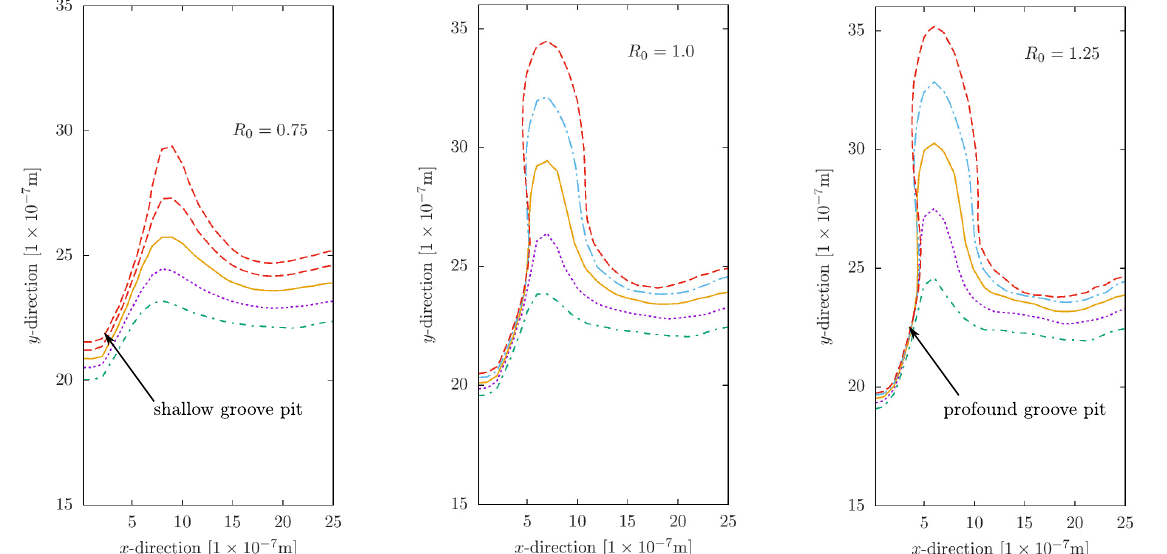
Figure 3. Effect of groove shape on the morphological development of primary ridges near a grain boundary. An increase in the ratio R 0 , where R 0 is the ratio between solid–solid γ gb to solid–liquid interfacial energies γ sl increases the local amplification of the ridge shaped instability. In contrast, a shallow groove due to an increase in the solid–liquid interfacial energy contribution (decreasing R 0 ) hinders the growth of the instability near the groove pit region. Various colored isolines represent different simulation timesteps.